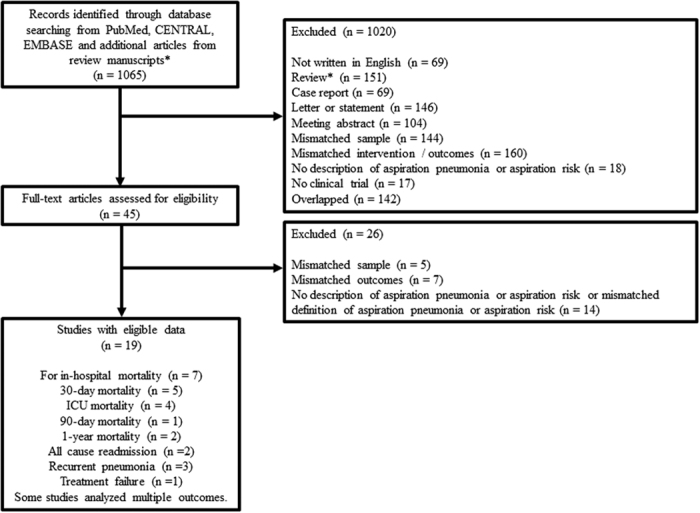
Flow diagram of the study selection.